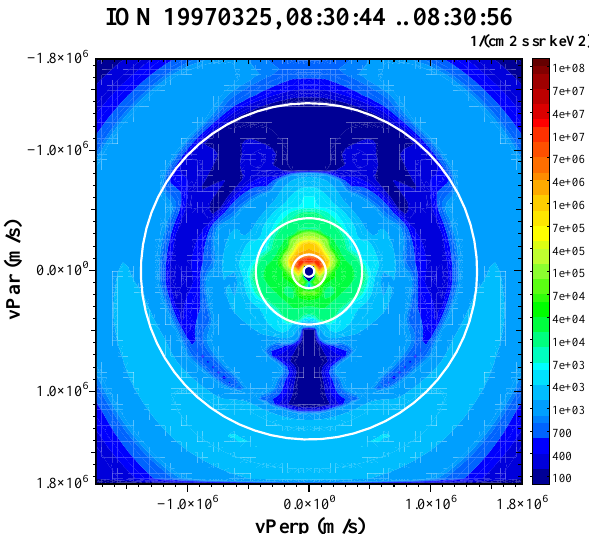
Fig. 13. Example of an event containing a full ion shell distribution whose downgoing part is stronger than the upgoing one, indicating a high-altitude source process which is becoming stronger with time. Format similar to 9. One-count level is 40 times smaller than shell level, MLT 0.9, ILAT 69, R = 4 . 8 R E , n = 0 . 15cm − 3 , T = 4 . 3keV, free energy density 0.08keVcm − 3